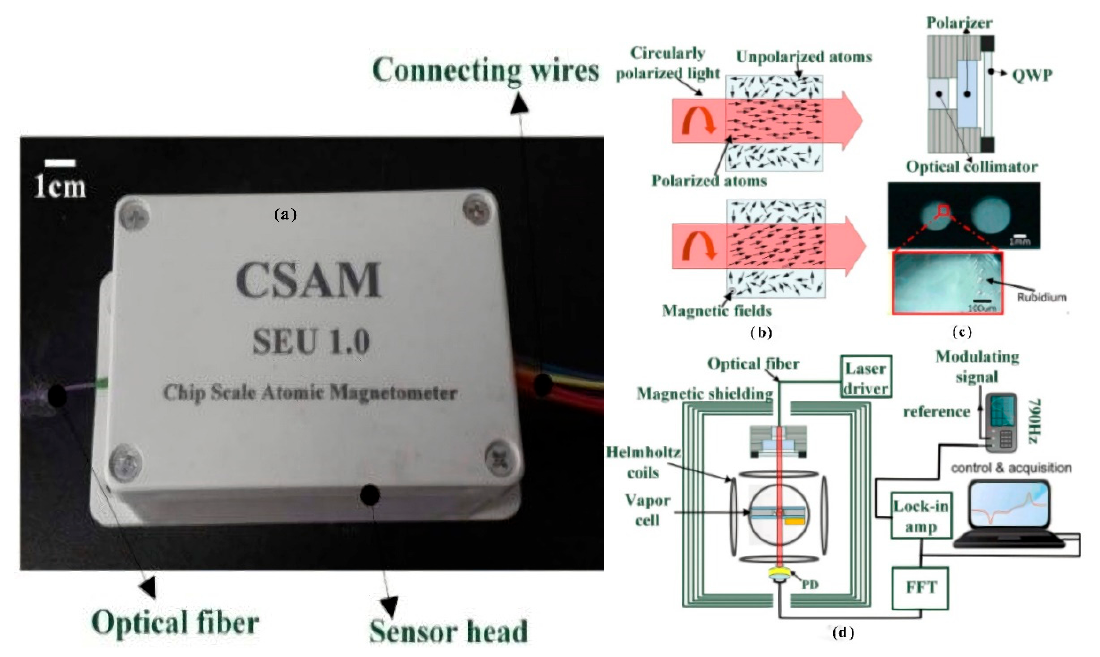
Figure 24. Magnetometer probe made utilizing micro-machining technology at Southeast University. ( a ) is atomic magnetometer, ( b ) is schematic, ( c ) is atom vapor cell, ( d ) is sensor structure diagram. Reprinted from ref. [111].